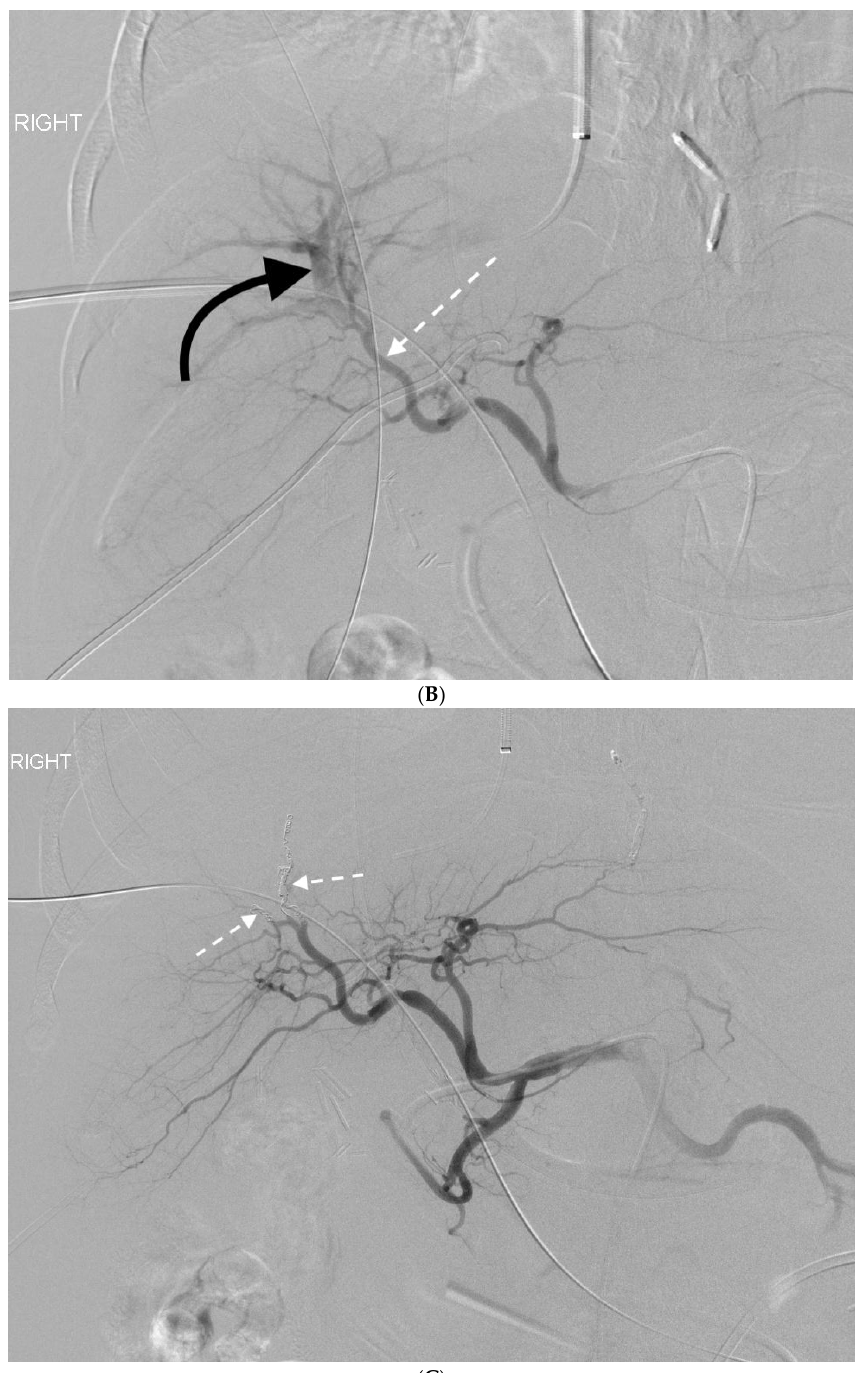
Figure 1. 56-year-old male with combined arterial-portal and portal-biliary fistulas. Patient underwent percutaneous transhepatic biliary drain (PTBD) placement for a biliary leak. One week later, he developed significant hemobilia. ( A ) Pullback cholangiogram through a sheath (thin black arrow) showed opacification of the biliary tree (thin white arrow) and portal vein (curved black arrow). ( B ) Hepatic artery angiogram showed a fistula between a branch of the right hepatic artery (dashed white arrow) and branch of the right portal vein (curved black arrow). ( C ) After transarterial embolization with coils (dashed white arrows), the arterial-portal fistula resolved. A new biliary drain was placed with proximal side holes central to the site of portal vein traversal. The patient’s hemobilia resolved. The portal vein and hepatic artery travel alongside the bile ducts in the portal triad and are at risk of injury during PTBD